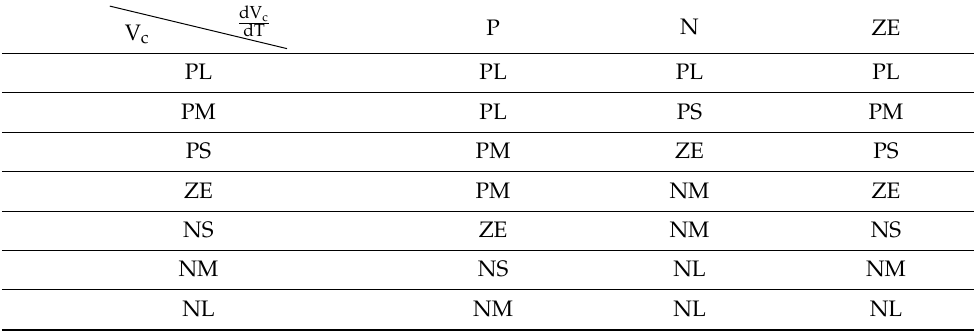
Table 3. Fuzzy rules based on fuzzy system inputs and output.